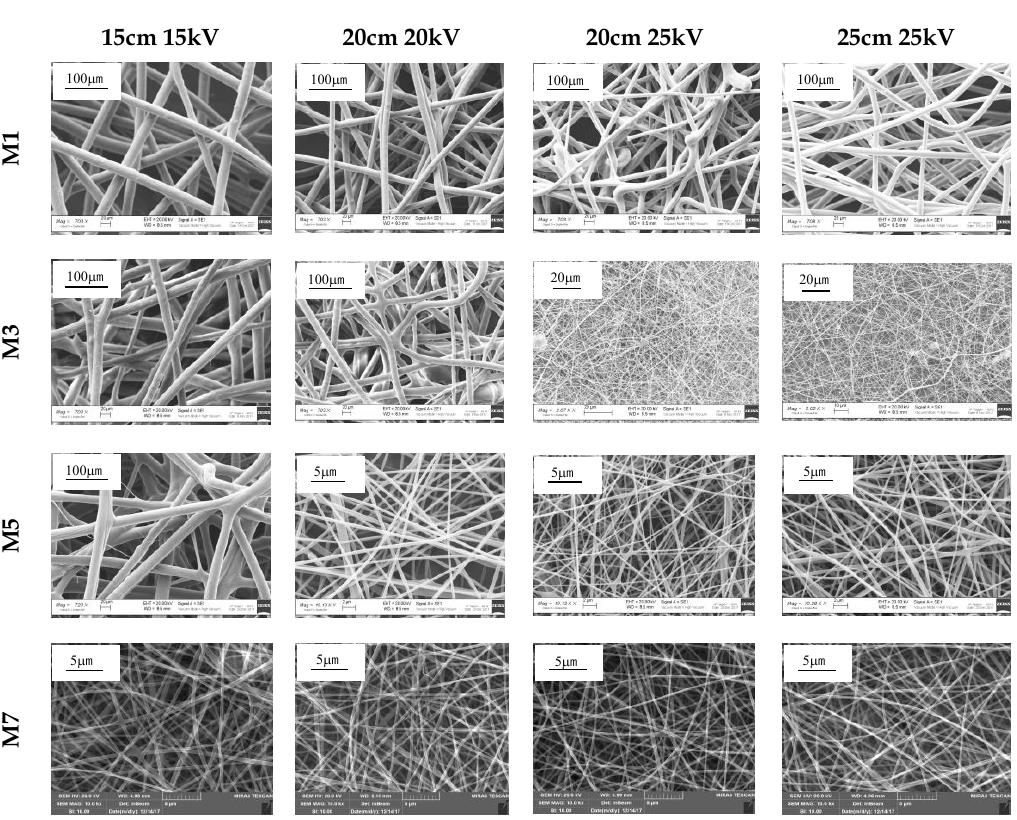
Figure 8. SEM micrographs of M1, M3, M5, and M7 fibers.